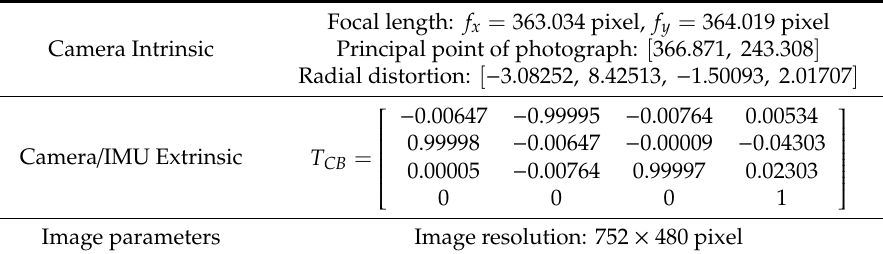
Table 4. Calibration parameters of camera and IMU.